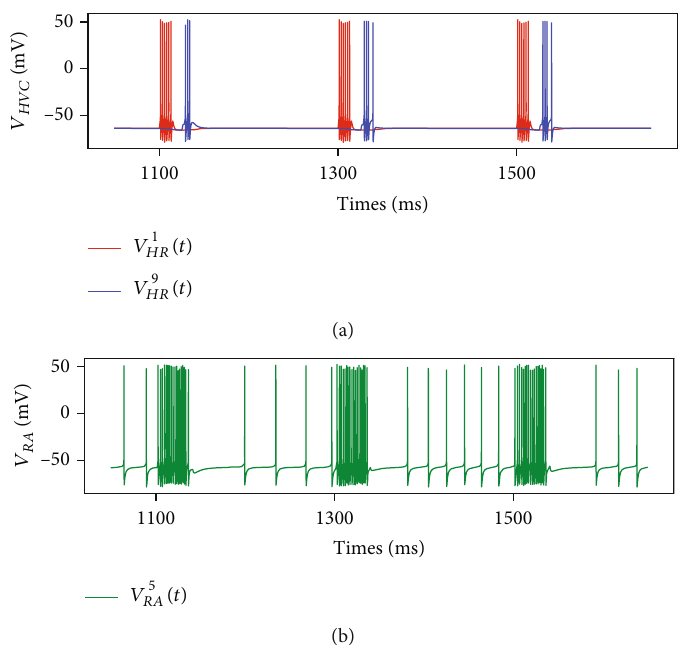
neurons are in the polarization state (a), RA neuron is stimulated with a DC of 12 mA to RA neurons fi re sparsely, and RA projection neurons show burst fi ring. Besides, it takes RA